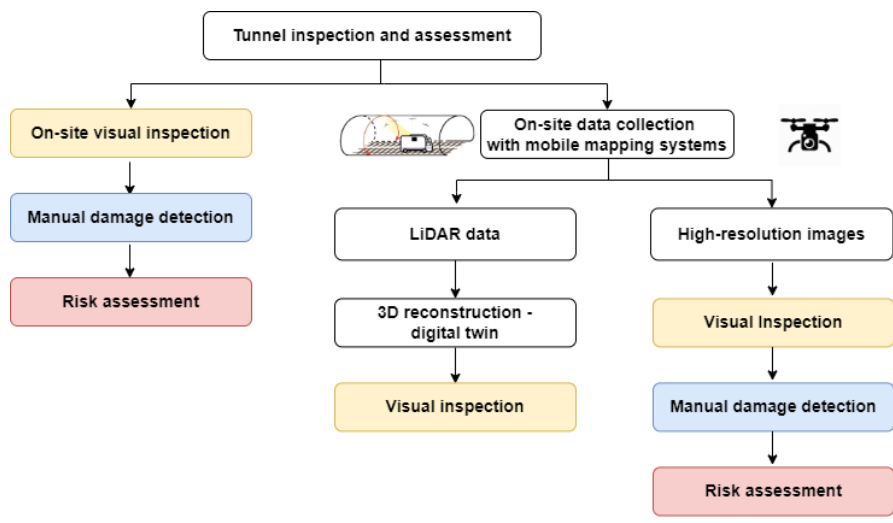
Figure 1. Standard procedure for tunnel inspection and